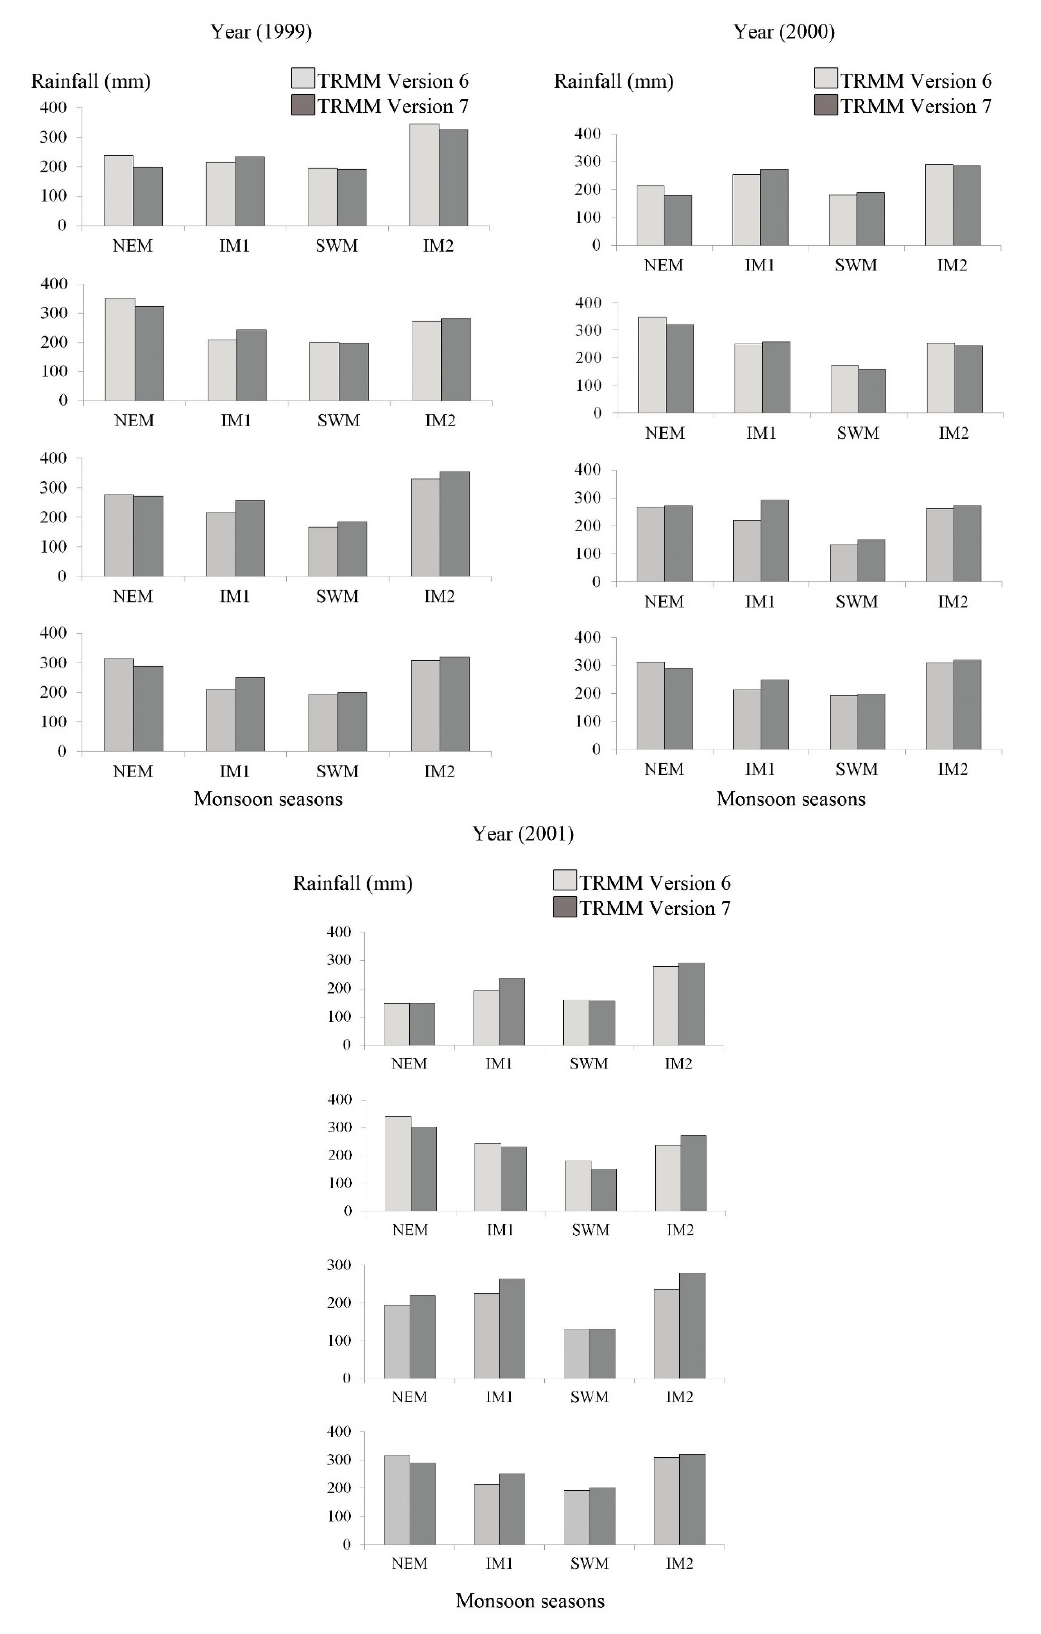
Figure A1. Average monthly rainfall derived from TRMM 3B43 version 6 and 7 for Peninsular Malaysia from 1999 to